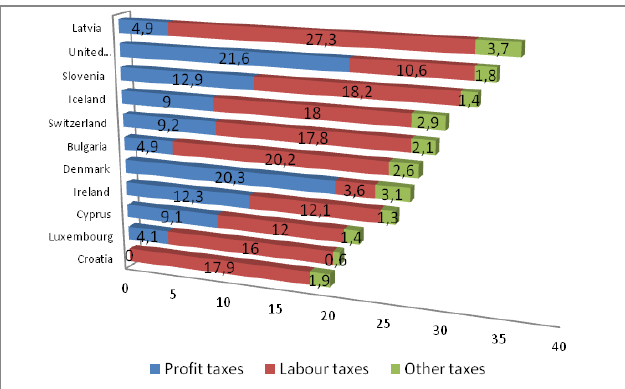
Fig. 2. Total tax rate, percentage in EU & EFTA (Source: Paying Taxes 2014: the global picture – a comparison of tax systems in 189 economies